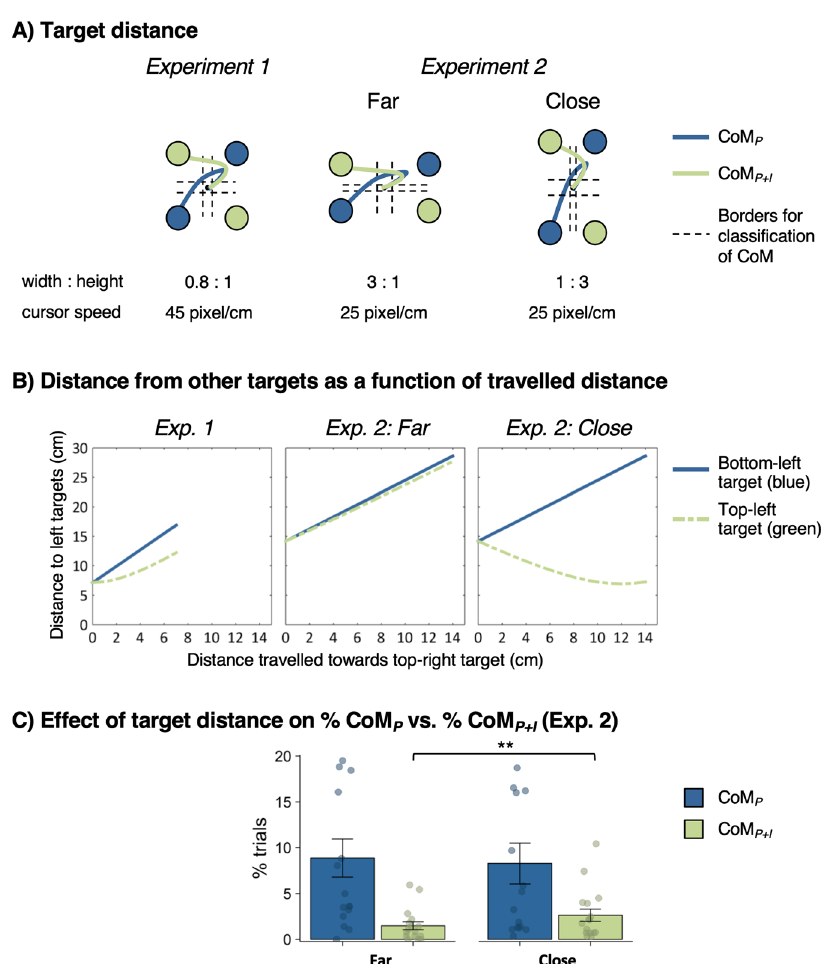
Fig. 3 Experiment 2: manipulation of horizontal target distance. A Target locations in Exp. 1 and 2. B Motor costs for each type of Change of Mind (CoM) as measured by the distance from the diagonal vs. horizontal target as a function of travelled distance (assuming straight movement trajectories towards targets). In the far-target condition, costs associated with each target were roughly equal, whereas in the close-target condition, the target of different colour was closer, hence rendering intention pursuit relatively more costly. C Effect of target distance on frequency of CoM P (blue) and CoM P + I (green) in Exp. 2 ( n = 16 participants). Data are presented as mean values ± 1 SEM ( ** p < 0.001). Dots represent data points from individual participants. (likelihood ratio test for logistic mixed-effects models: ** p < 0.001; no correction for multiple